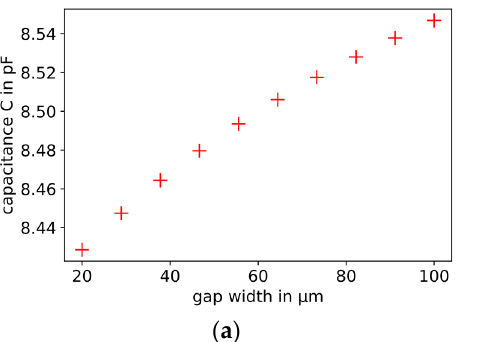
displacement measurements. With increasing gap width, the slope error increases linearly and the nonlinearity exponen-